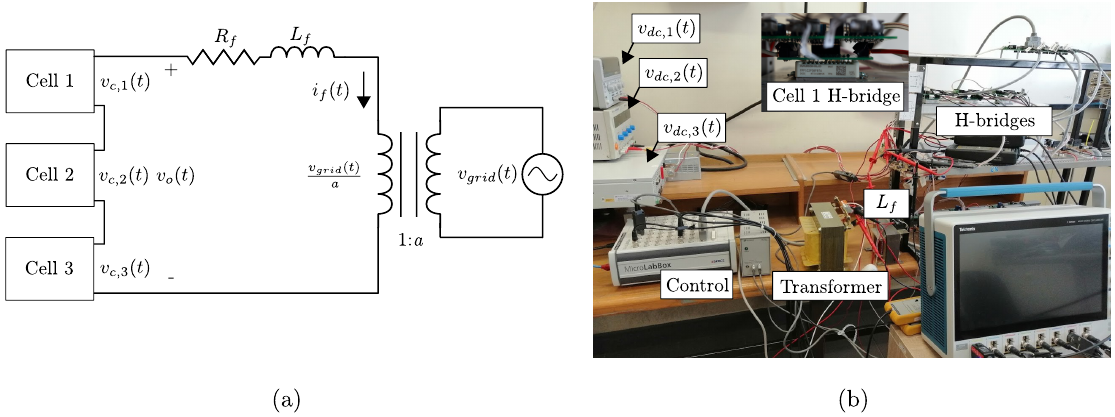
Figure 6. System used for the experimental tests. ( a ) electrical diagram; ( b ) experimental